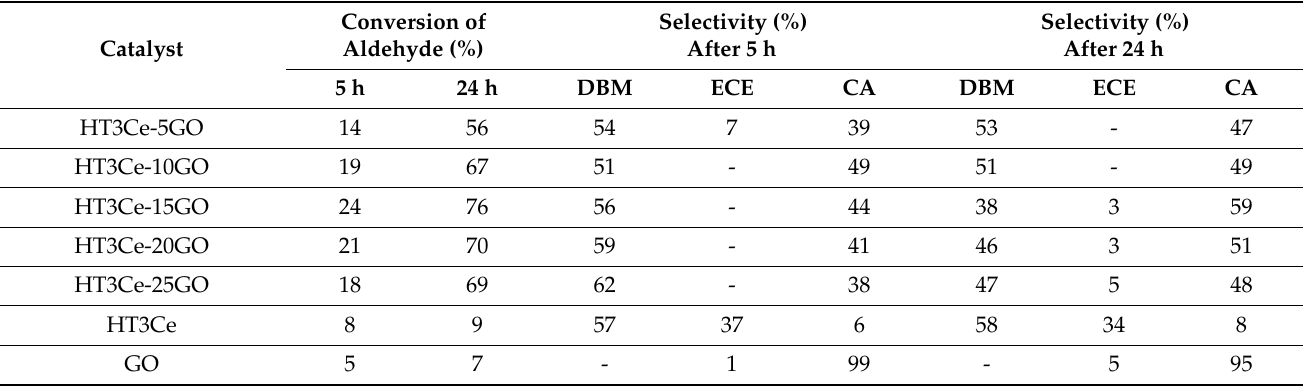
Table 4. Catalytic results of the HT3Ce-xGO composites containing five different concentrations of GO ( x = 5, 10, 15, 20, 25 wt. % GO) at 5 and 24 h reaction